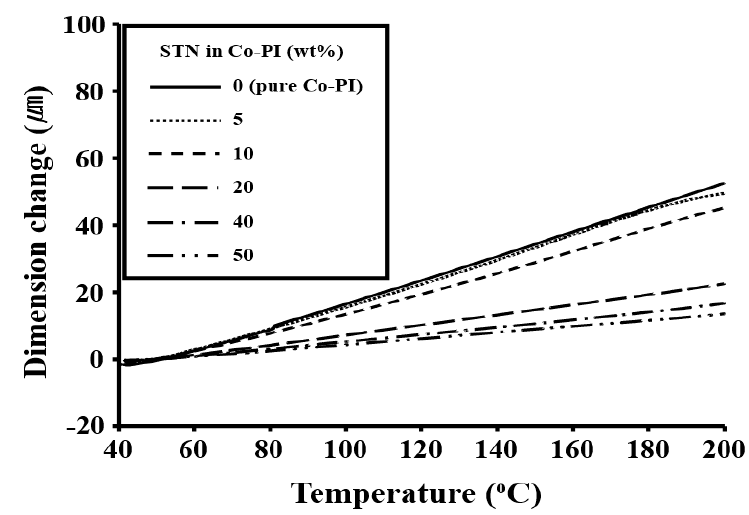
Figure 10. TMA thermograms of the Co-PI hybrids with various STN concentrations.